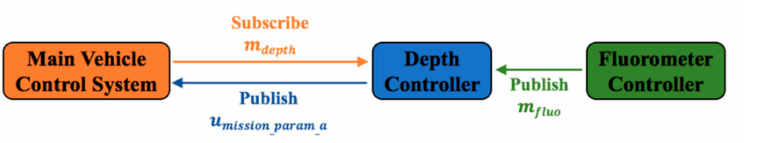
Figure 24. The control structure of the glider with a backseat driver, which takes the measurements from a fluorometer for adaptive depth control.